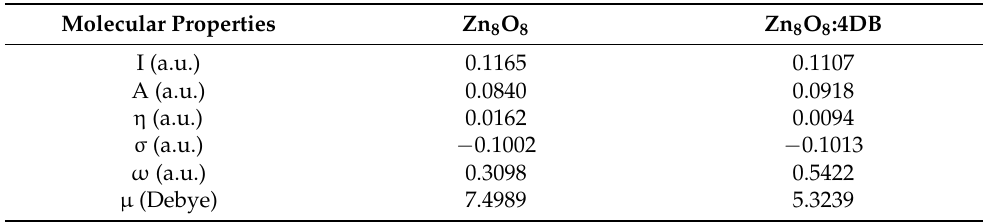
Table 3. Calculated values of ionization energy (I), electron affinity (A), global hardness ( η ), chemical potential ( µ ), global electrophilicity index ( ω ) and dipole moment ( µ ) for the Zn 8 O 8 and Zn 8 O 8 :4DB clusters using the B3LYP/6-311 G(d, p)